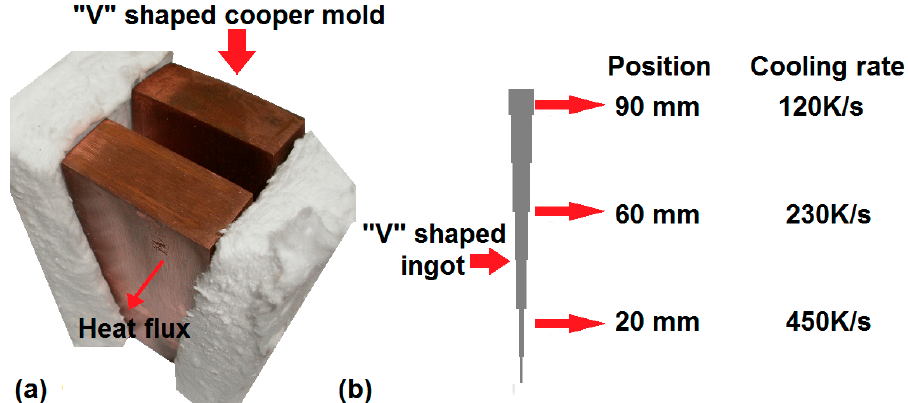
Figure 1. ( a ) Wedge ‐ shaped copper mold isolated in both sides by an alumina sheet; ( b ) “V” shaped ingot showing three different cooling rate zones: 90 mm high: 120 K/s, 60 mm high: 230 K/s, and 20 mm high: 450 K/s.